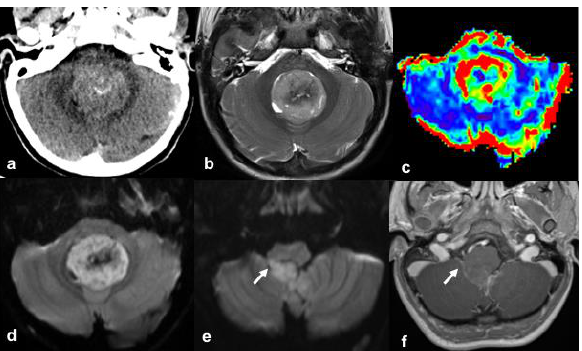
Figure 1. Axial computed tomography (CT) ( a ) and magnetic resonance imaging (MRI) (T2w ( b ); arterial spin labeling ( c ); diffusion weighted imaging ( d , e ); GdT1 ( f )) axial images. CT study shows a fourth ventricle mass with lesional mineralizations ( a ). The tumor has a heterogeneous signal on MRI ( b ), increased perfusion ( c ), restriction of the diffusivity ( d ), and mild contrast enhancement ( f ). Furthermore, the involvement of the right foramen of Luschka is noted (arrow, ( e , f